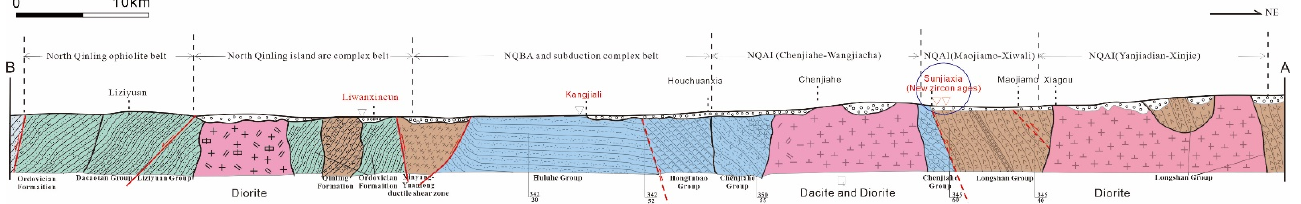
Figure 3. The geological section crossing the study area, with occurrence of representative structures and